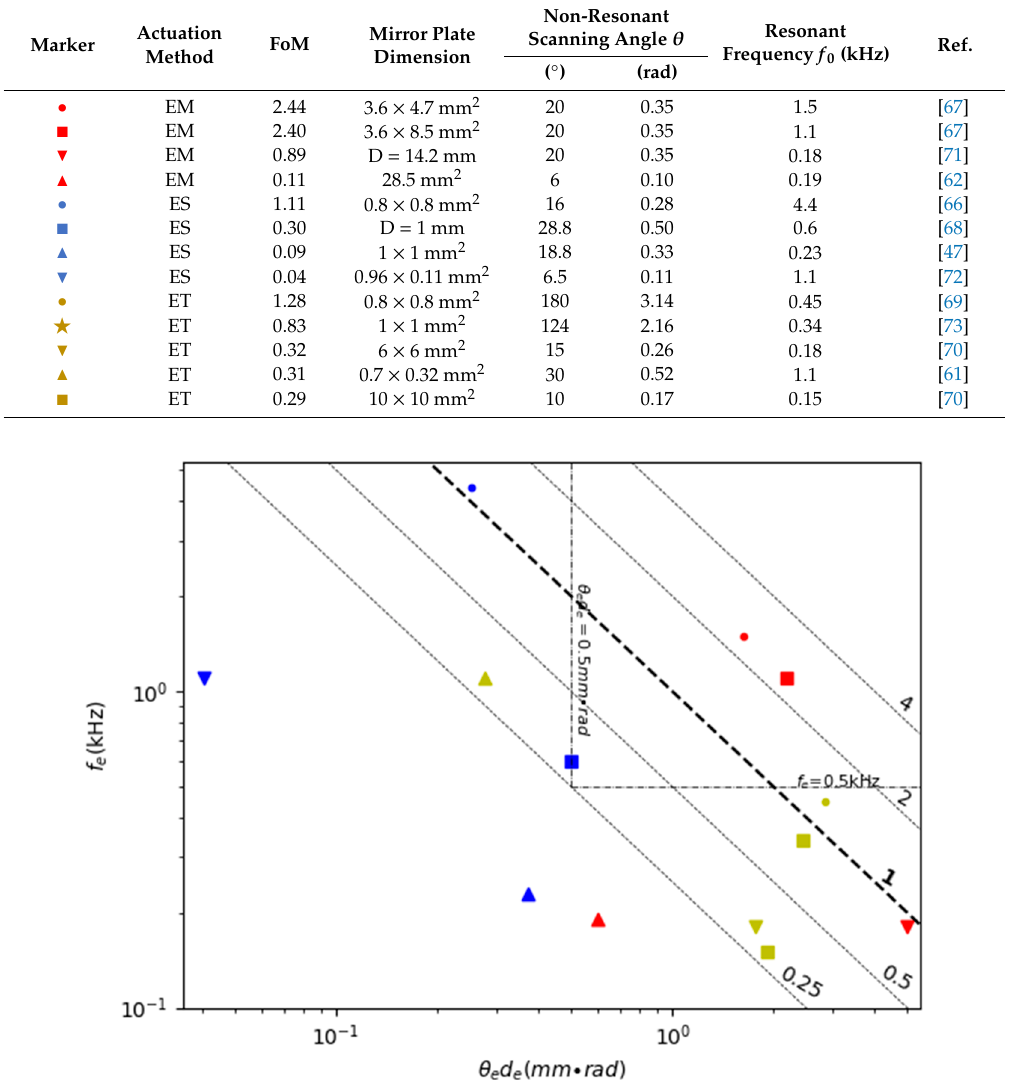
Figure 7. A comparison of 1D non-resonant scanning MEMS mirrors.